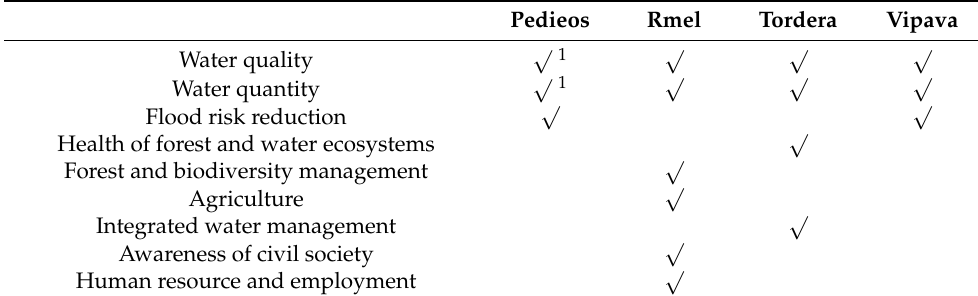
Table 3. Climate change related challenges per river basin.